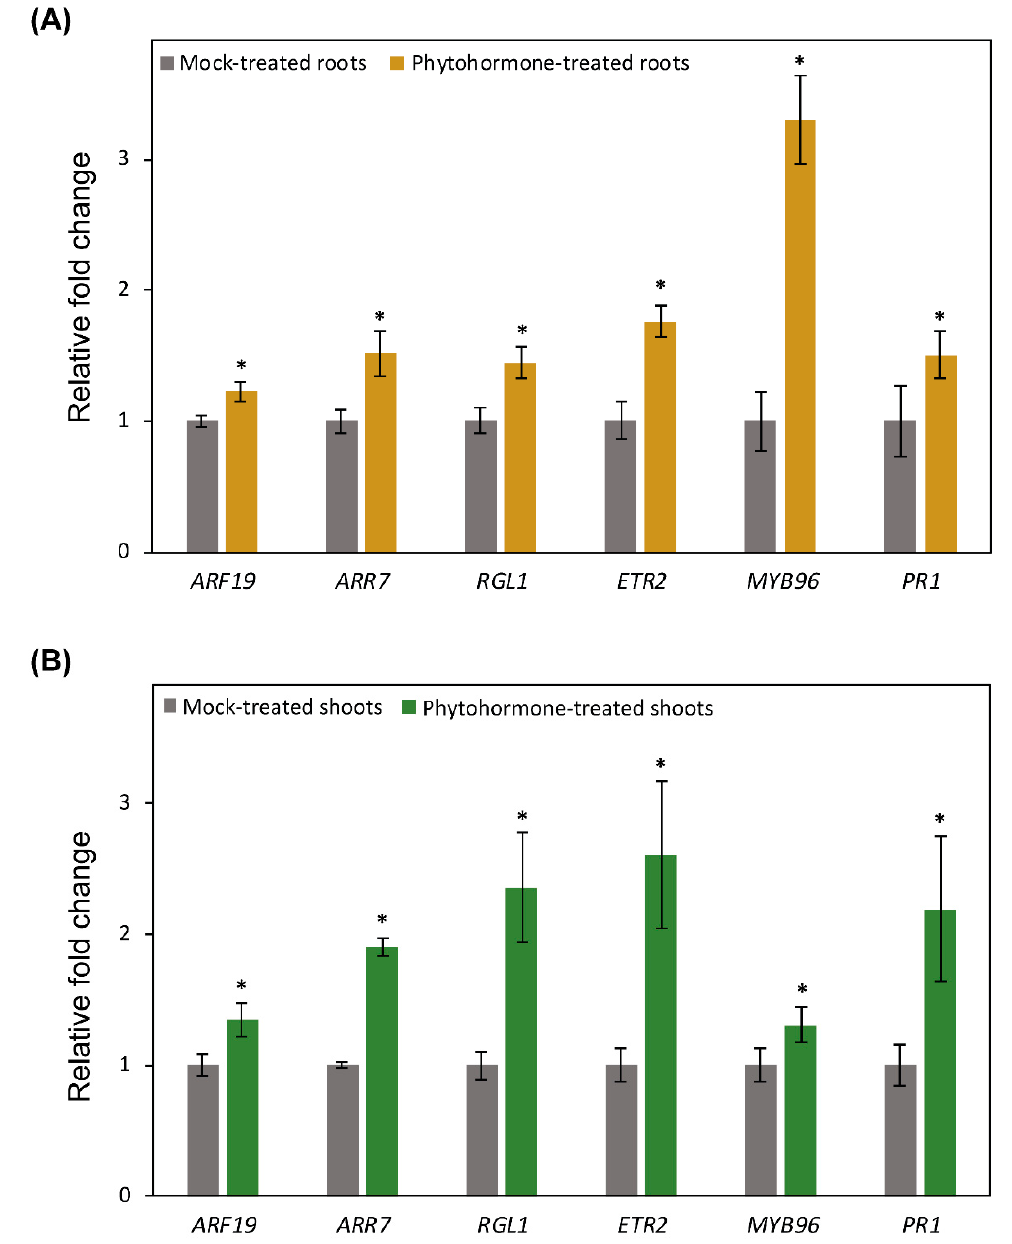
Figure 5. Upregulation of phytohormone marker genes after hormone application. A and B: The expression levels of marker genes for auxin ( ARF19 ), cytokinin ( ARR7 ), gibberellic acid ( RGL1 ), ethylene ( ETR2 ), abscisic aid ( MYB96 ), and salicylic acid ( PR1 ) response were quantified in roots ( A ) and shoots ( B ) of treated and control wild-type Col-0 plants 24 h after hormone application. Relative fold change values were calculated from three biological samples and represent expression in hormone-treated plants relative to mock-treated plants. Actin8 and PP2AA3 were used as internal control to normalize gene expression values. Average CT (cycle threshold) values of Actin8 and PP2AA3 were used to calculated ΔΔ CT values and gene expression levels. Asterisks indicate statistically significant differences between hormone-treated and mock-treated plants at p < 0.05 according to t -test.